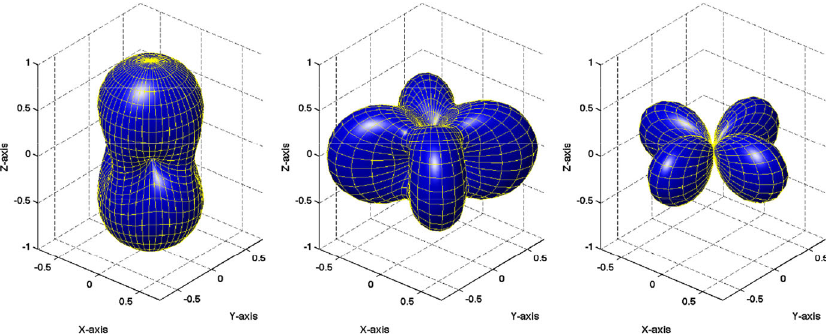
Fig. 65 Antenna patterns for Michelson interferometer strain response to unpolarized gravitational waves for tensor ( left plot ), vector ( middle plot ), ans scalar modes ( right plot ), evaluated in the small antenna limit, f = 0. The interferometer arms point in the ˆ x and ˆ y